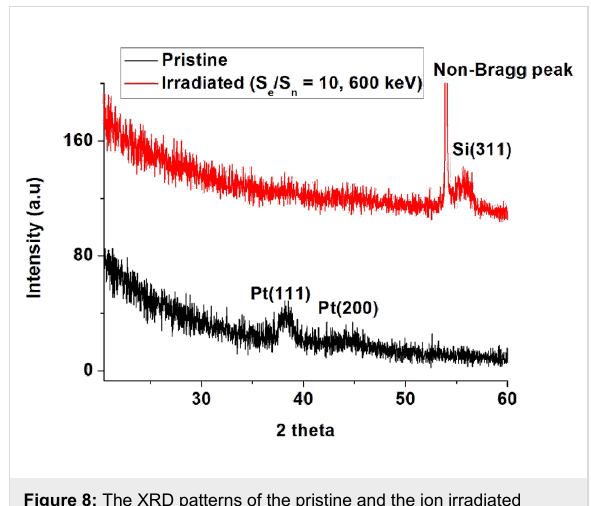
Figure 8: The XRD patterns of the pristine and the ion irradiated ( S e / S n = 10)